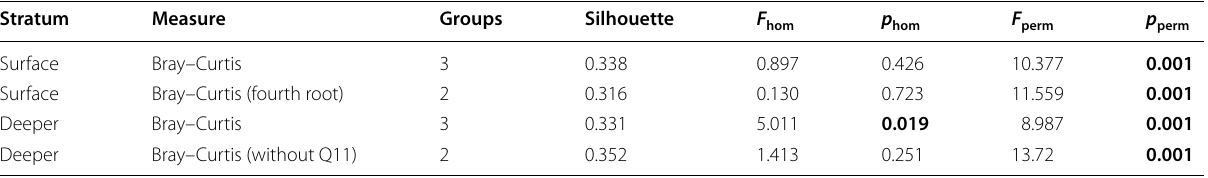
Table 1 Results of the silhouette coefficient, homoscedasticity and PERMANOVA tests for the zooplankton groupings from the surface and deeper strata identified in the nMDS analysis. The measure and data transformations are indicated. In bold p (perm) < 0.05